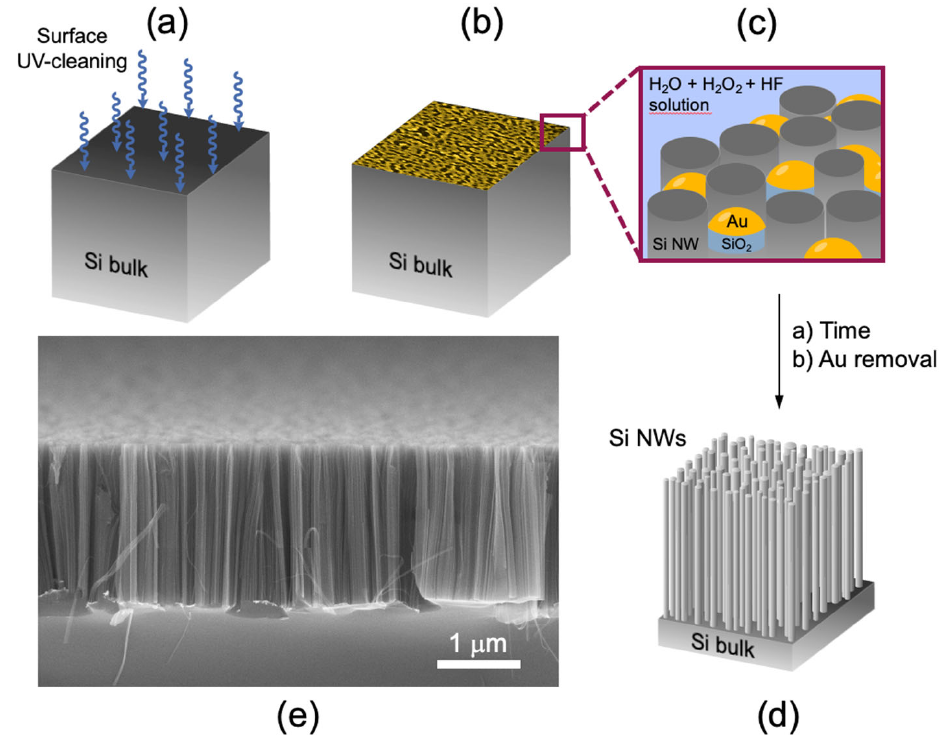
Figure 1. Scheme of the metal-assisted chemical-etching approach used for the Si NWs synthesis ( a – d ). SEM image of Si NWs in tilted cross-section view ( e ).